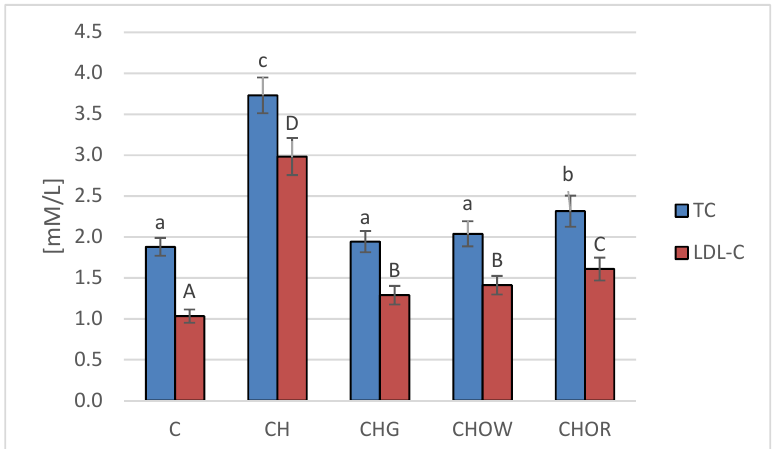
Figure 1. Changes in the plasma lipid profile (TC and LDL-C) in rats fed control and cholesterol- containing (1% of cholesterol) diets, supplemented with lyophilized vegetables (garlic, white onion, and red onion) during the 28 day experiment. Values are means of 6 measurements ± SD. Means in columns with different superscripts letters in common differ significantly ( p < 0.05): a–c indicate values for TC and A–C indicate values for LDL-C. Abbreviations: C—control group; CH—control group with 1% of cholesterol; CHG—group with 1% of cholesterol and lyophilized garlic addition; CHOW—group with 1% of cholesterol and lyophilized white onion addition; CHOR—group with 1% of cholesterol and lyophilized raw red onion addition; TC—total cholesterol, LDL-C—low-density lipoprotein cholesterol fraction.